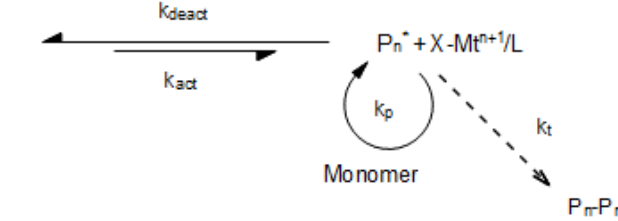
Figure 17. ATRP Equilibrium; k p —propagation reaction rate constant; k t —termination reaction rate constant [64].